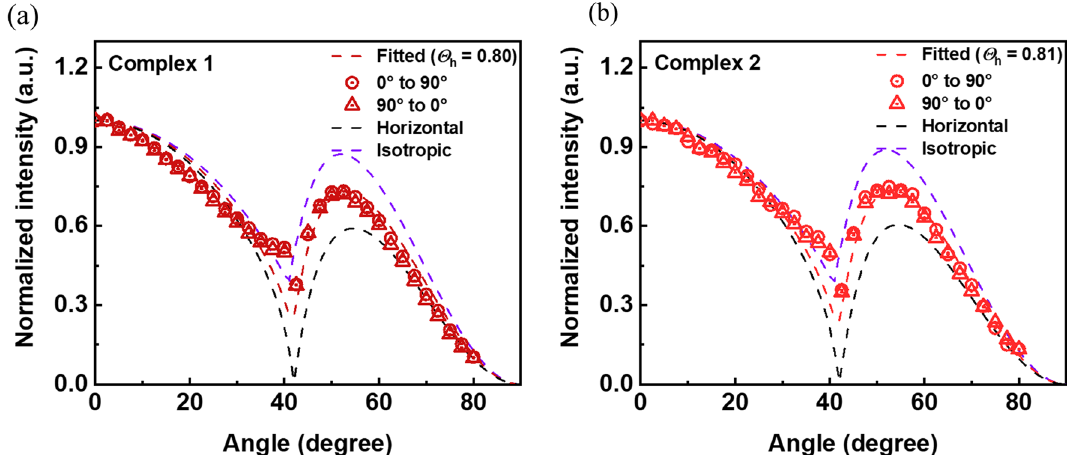
Figure 4. Angular dependence of PL intensity of ( a ) Ir(mCPDTiq) 2 tmd, ( b ) Ir(mCPDTiq) 2 acac. Fitted line (experimental data), horizontal and isotropic line (simulation) of dipole